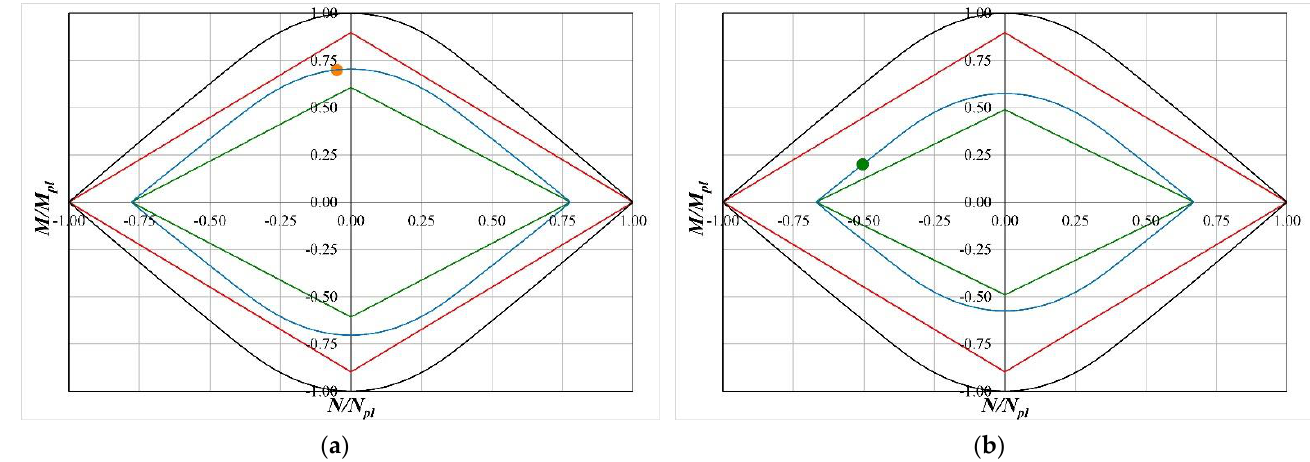
Figure 12. Dimensionless domains: IPE400 elastic (red line); IPE400 yield (black line); LRPD elastic (green line); LRPD yield (blue line). ( a ) design point 1; ( b ) design point 2.